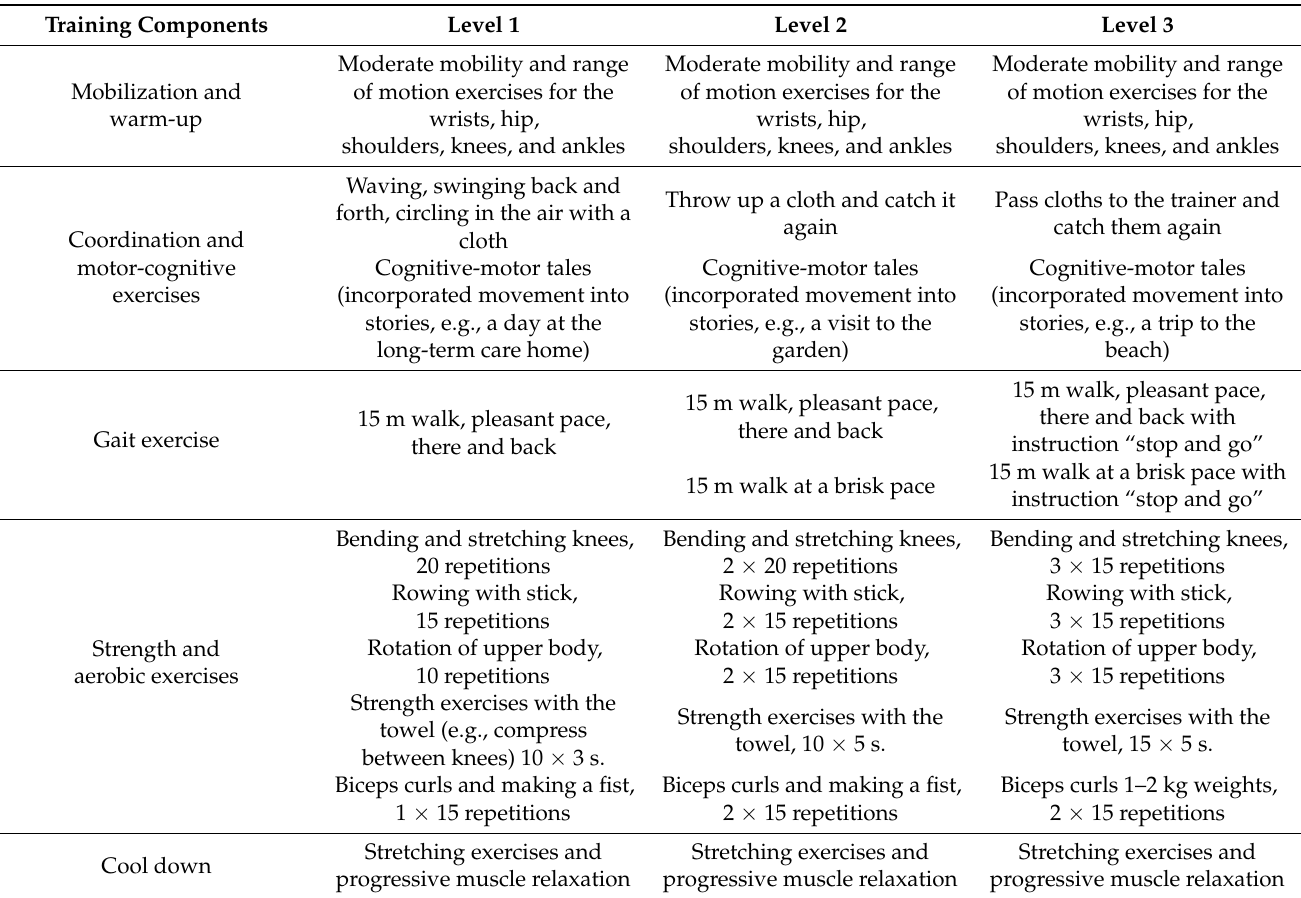
Table A1. Exercise examples of a training session with progression of